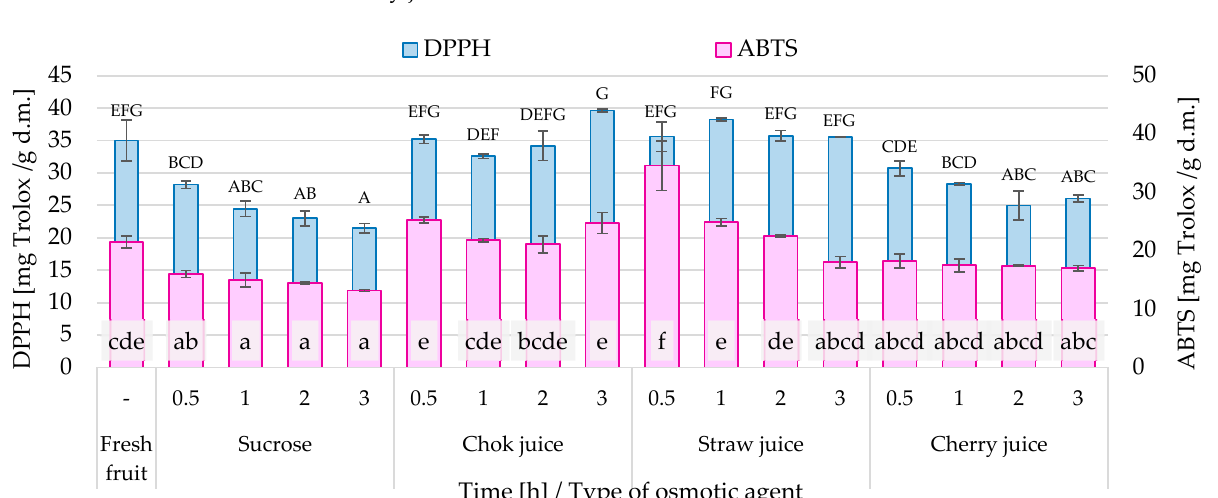
Figure 6. Effect of the type of osmotic agent (sucrose and fruit concentrates) on the total polyphenol content and anthocyanin content in osmodehydrated strawberries. Different letters (small letters are for anthocyanin content, capital letters are for total polyphenol content) above columns show the statistical difference ( p < 0.05).